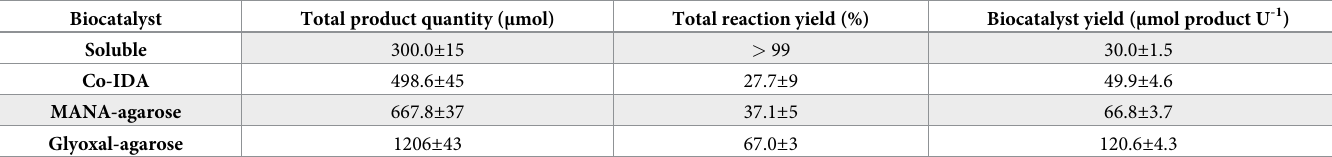
Table 3. Total product quantity, total reaction yield and biocatalyst yield for the synthesis of pre-D-fagomine using immobilized FSA in 6 reaction cycles and solu- ble FSA in a single cycle. Reactions conditions: 1 U mL -1 , 10 mL reaction volume, 30 mM β -CHO, 45 mM DHA and 50 mM HEPES buffer, pH 8.0, 25˚C, orbital stirring.